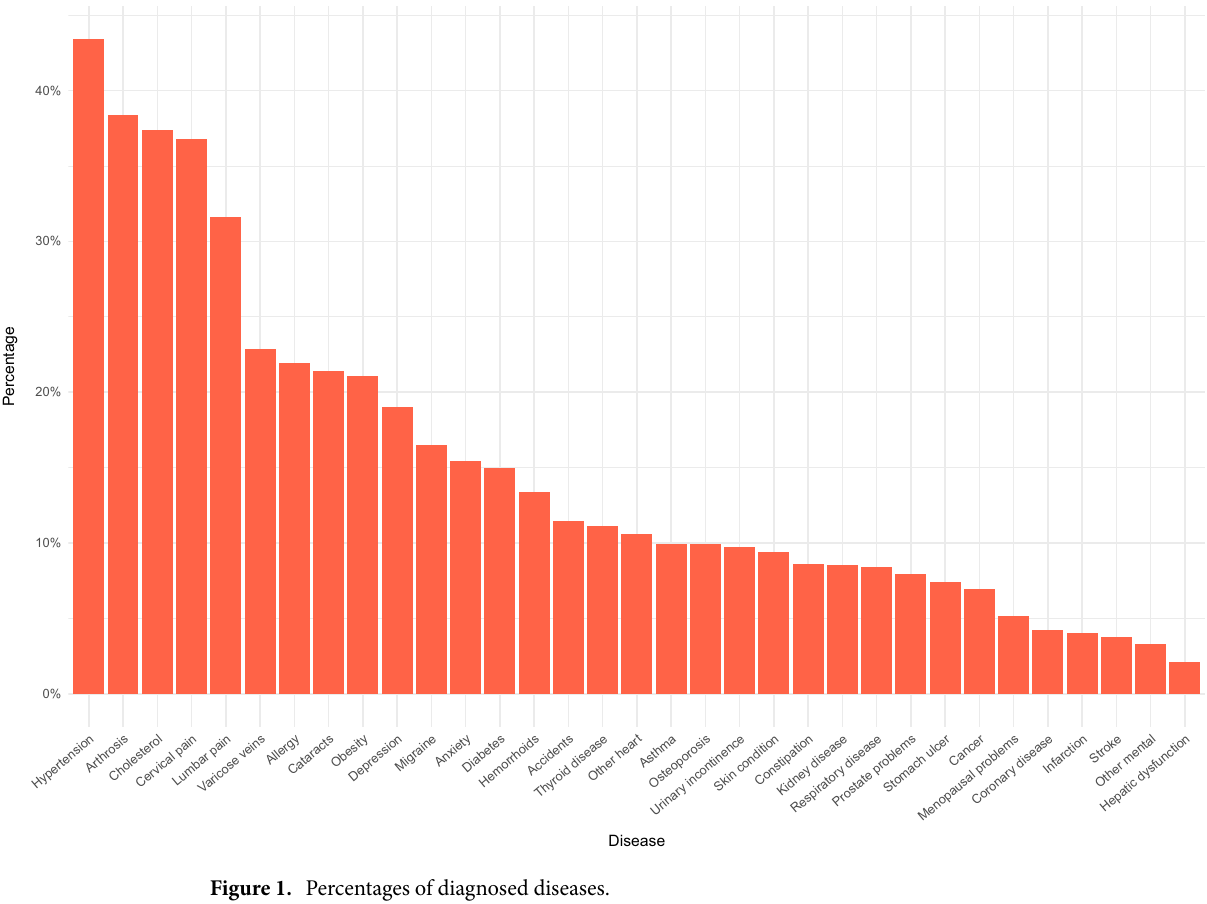
Figure 1. Percentages of diagnosed